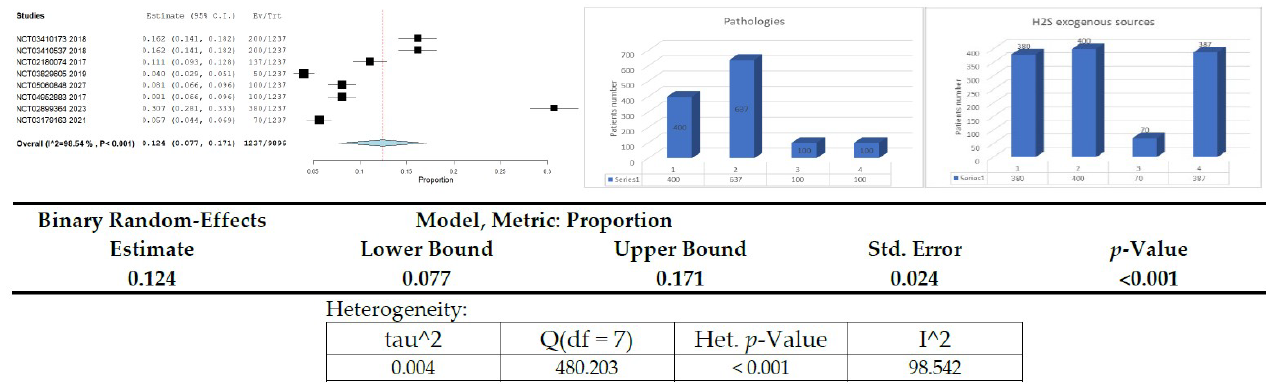
Figure 3. Forest plot related to patients number included in each clinical trial selected for this study. Table 3. The clinical trials that satisfied all the previous filtering criteria/PRISMA stages selected for qualitative synthesis were included in our meta-analysis to determine the using frequency of the hydrogen sulfide-based interventions for DM or related associated